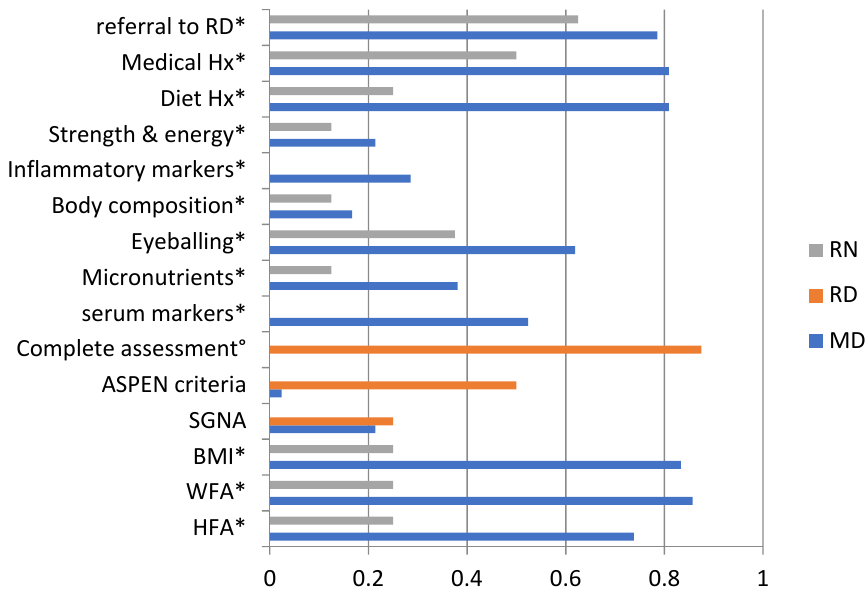
Figure 2. Approaches to nutritional assessment in Canadian tertiary pediatric hospitals by health